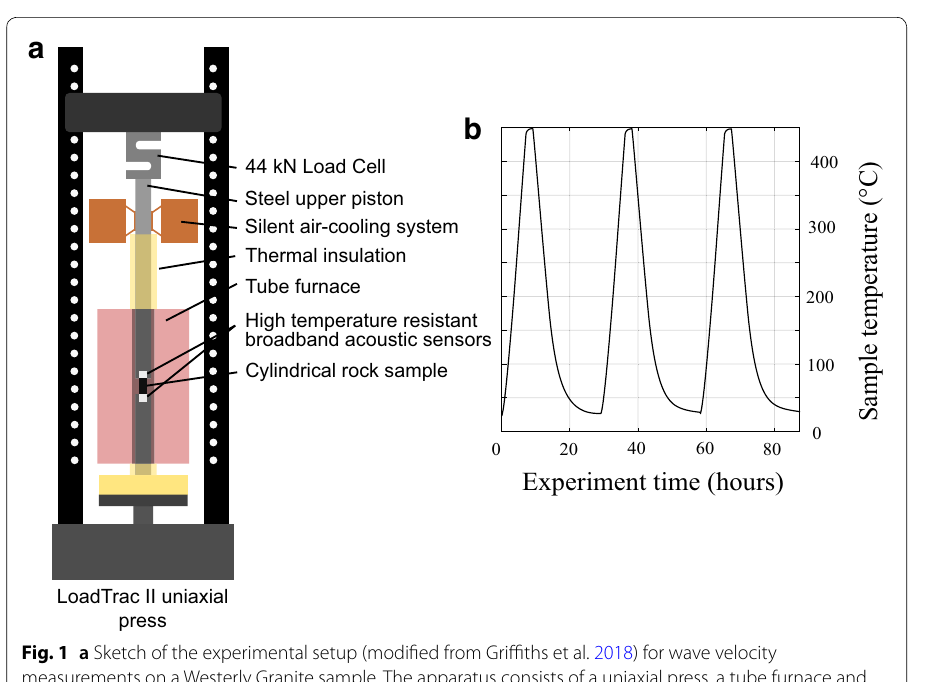
Fig. 1 a Sketch of the experimental setup (modified from Griffiths et al. 2018) for wave velocity measurements on a Westerly Granite sample. The apparatus consists of a uniaxial press, a tube furnace and for waveform measurements, a pair of high temperature resistant and broadband acoustic sensors that are set in direct contact with opposing ends of the sample [see Griffiths et al. (2018) for details]. Upper acoustic sensor is the source and the lower one is the receiver. b Evolution with time during three heating/cooling cycles, of the temperature measured at the center of the sample with a thermocouple inserted into a hole drilled